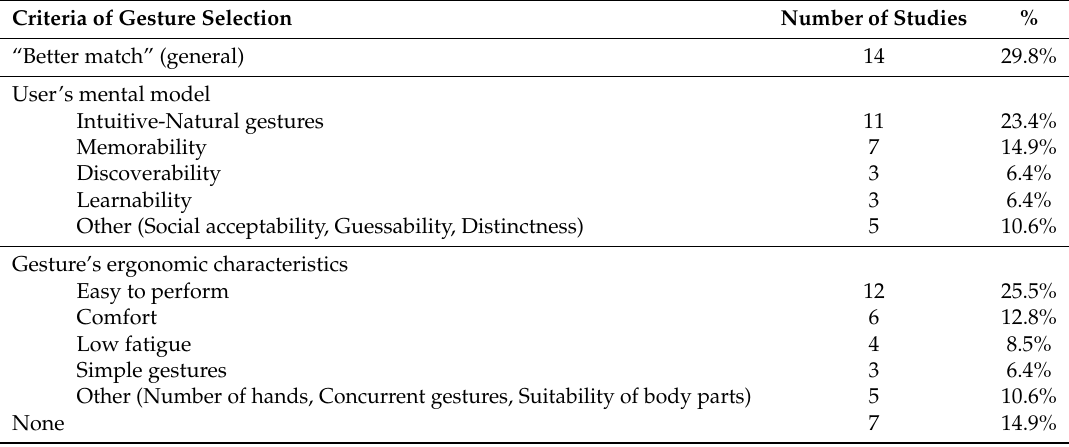
Table 5. Criteria of gesture